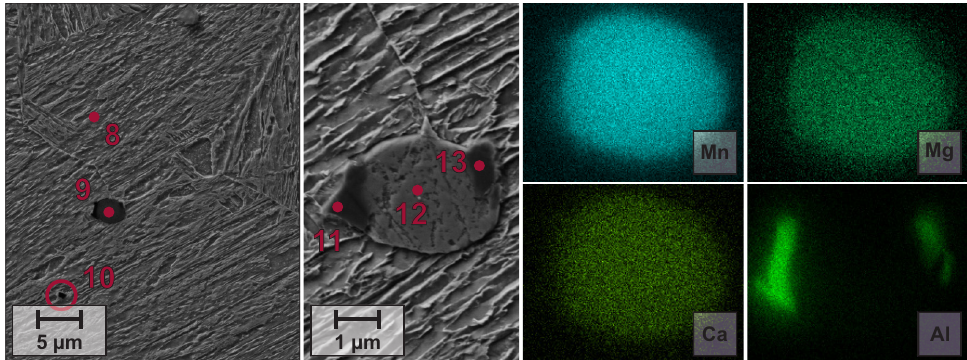
Figure 11. Microstructure of steel “M” observed by SEM. Different types of precipitates are displayed and the positions of EDX analyses are indicated. The figure is completed by an EDX mapping of aluminum and manganese, as well as the trace elements magnesium and